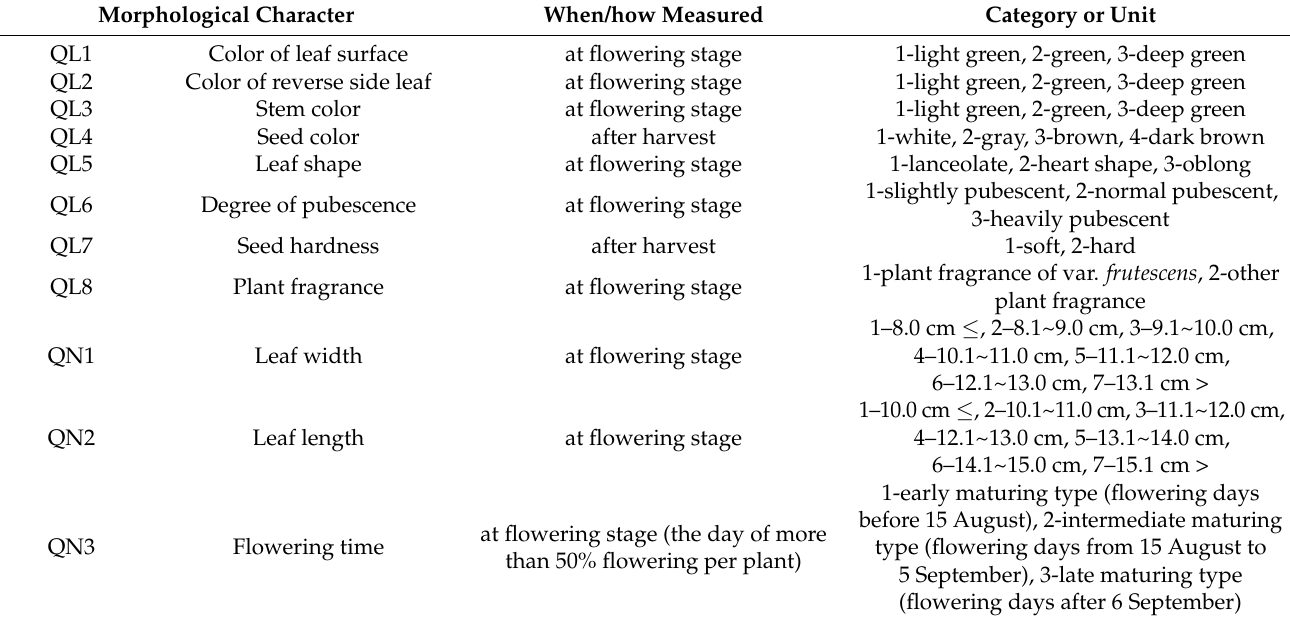
Table 4. Characters used in the morphological analysis of the 183 accessions of native Perilla frutescens var. frutescens of Perilla